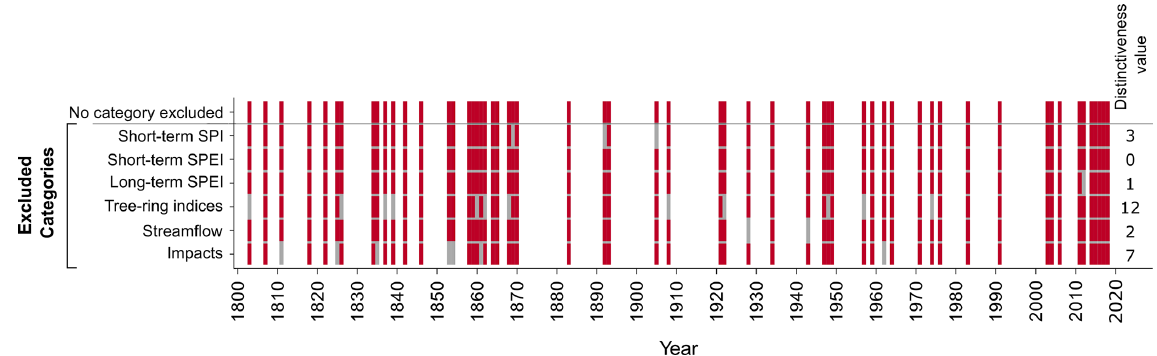
Figure 7. Extreme drought events identified (red) or missed (gray) when excluding a certain category from drought indices. Each row shows the droughts that are identified when one of the categories is excluded from the analysis, therefore showing the events unique to this category. The total number of missed events (distinctiveness value) when excluding a certain group of indices is displayed on the